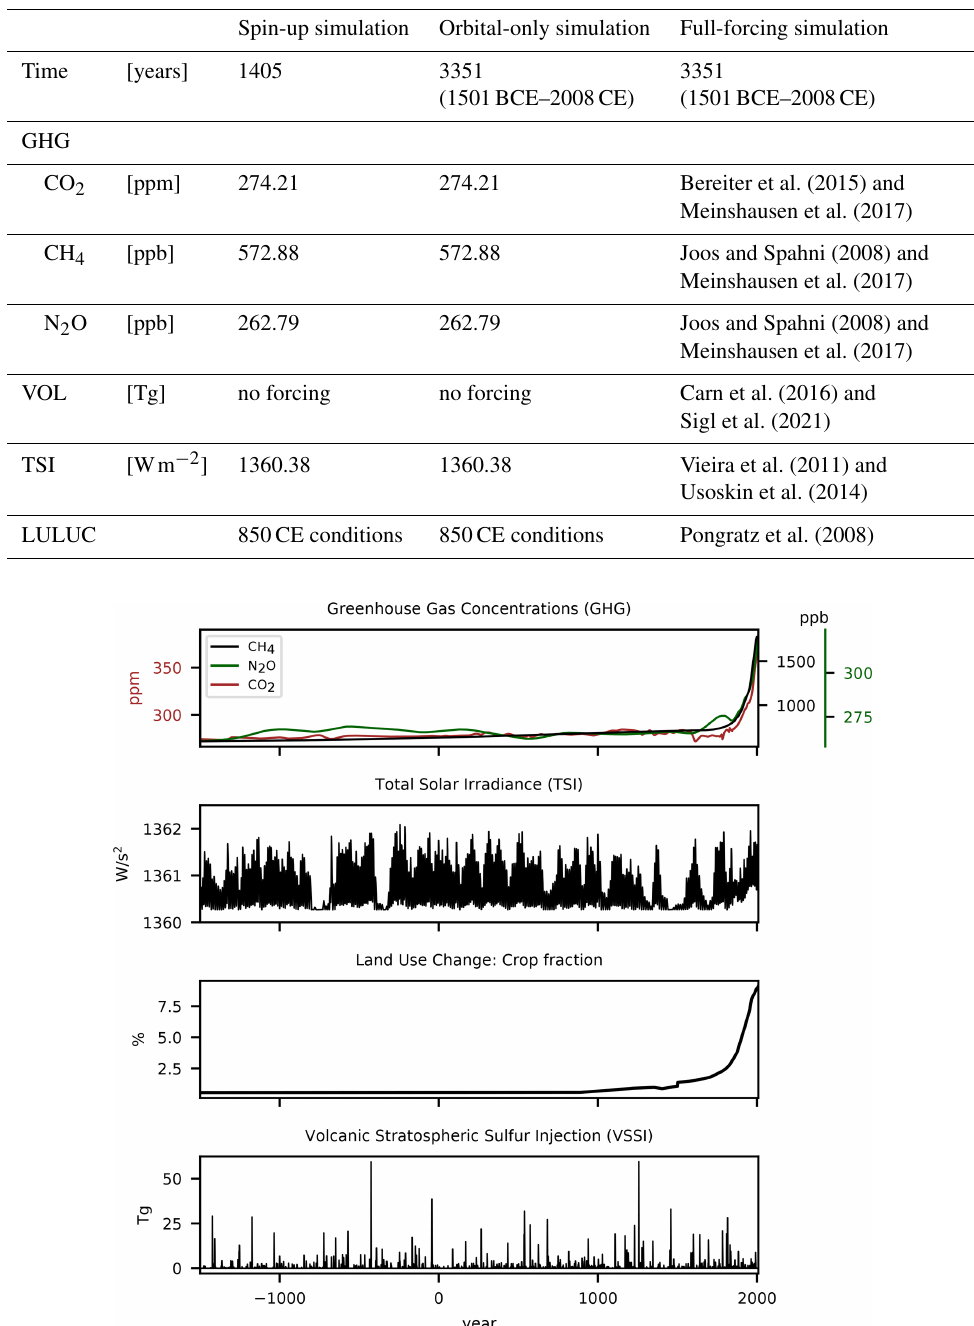
Table 1. Forcing values for the simulations. The time-varying forcing in the last column is presented in Fig. 1. Spin-up simulation